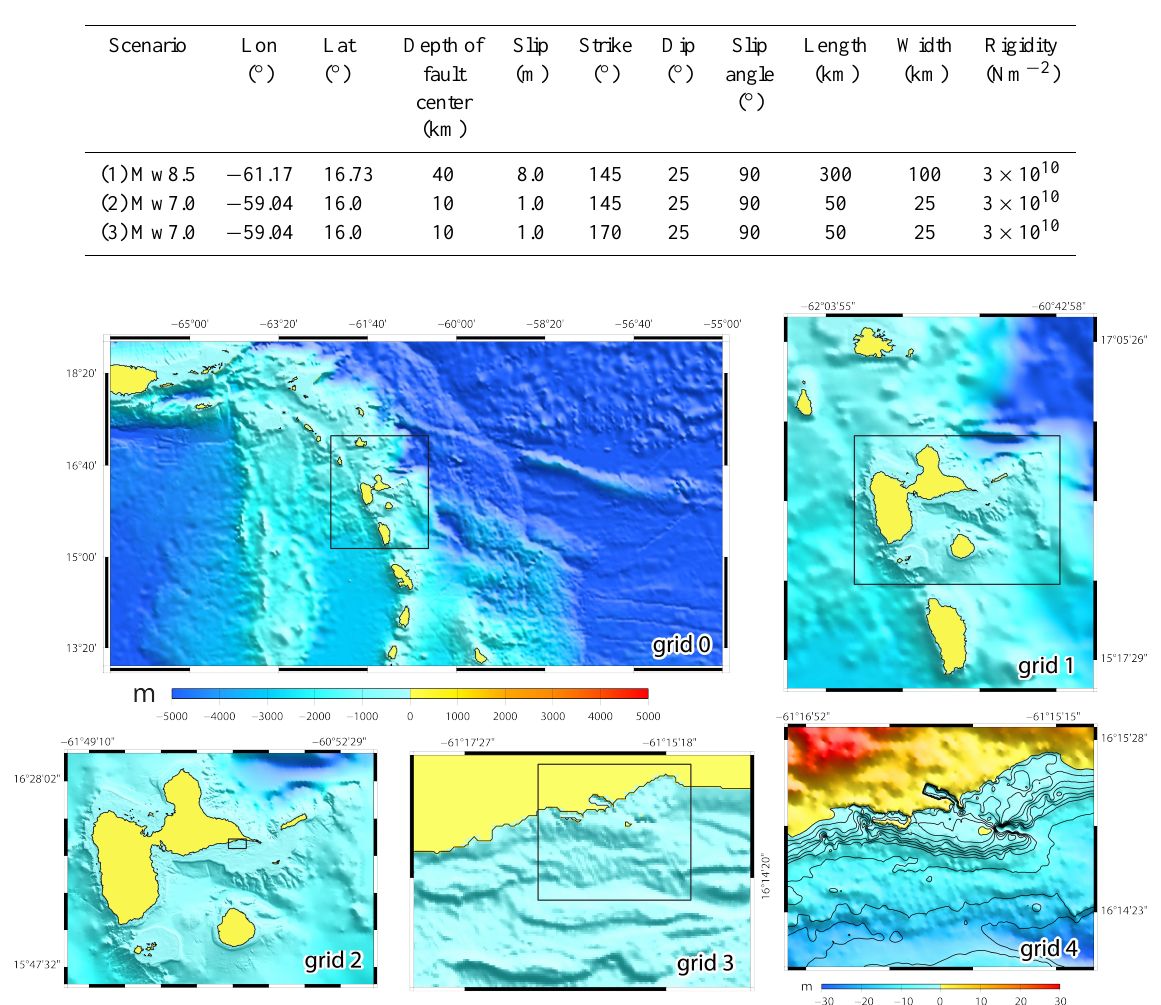
Fig. 4. Digital elevation grids used for numerical modeling from level 0 (resolution 1’) to level 4 (resolution 10m – the black lines represent isobaths every meter from 0 to − 5m and then every 5m) used with the CEA code. Black rectangles symbolize the grid-level